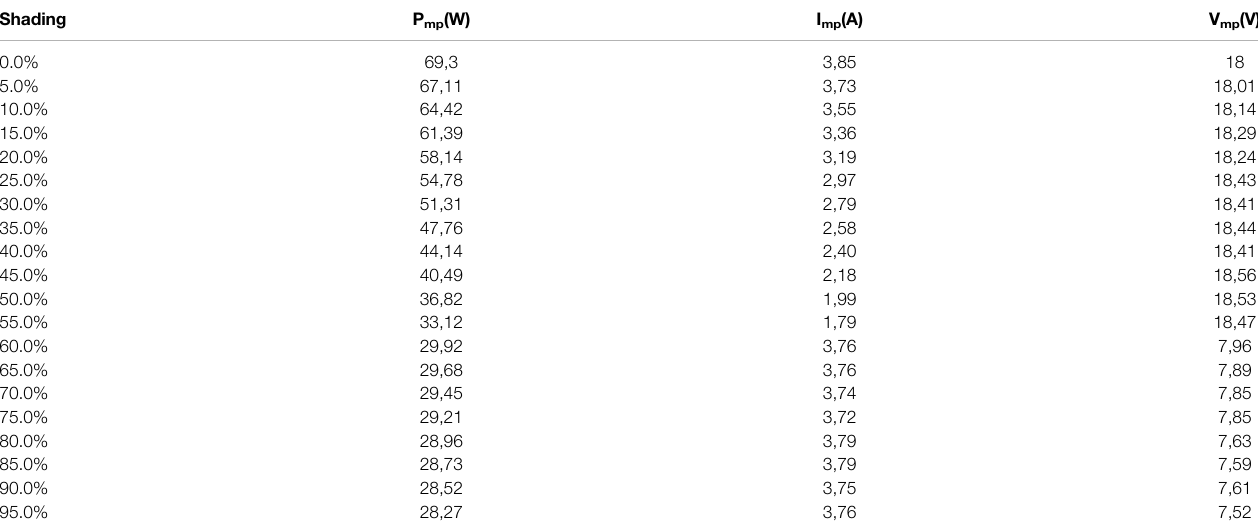
TABLE 4 | Annual variation of electrical parameters. Shading P mp (W) I mp (A) V mp (V)